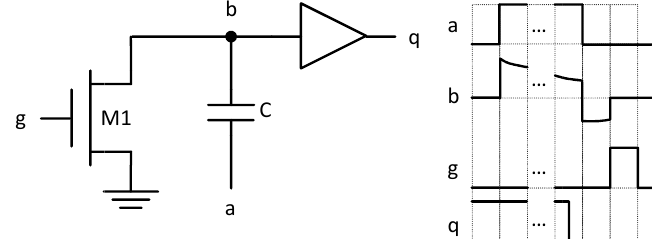
Figure 3. Charging circuitry explanation: On the left, the charge pump example circuit. On the right, transient signals for the charge